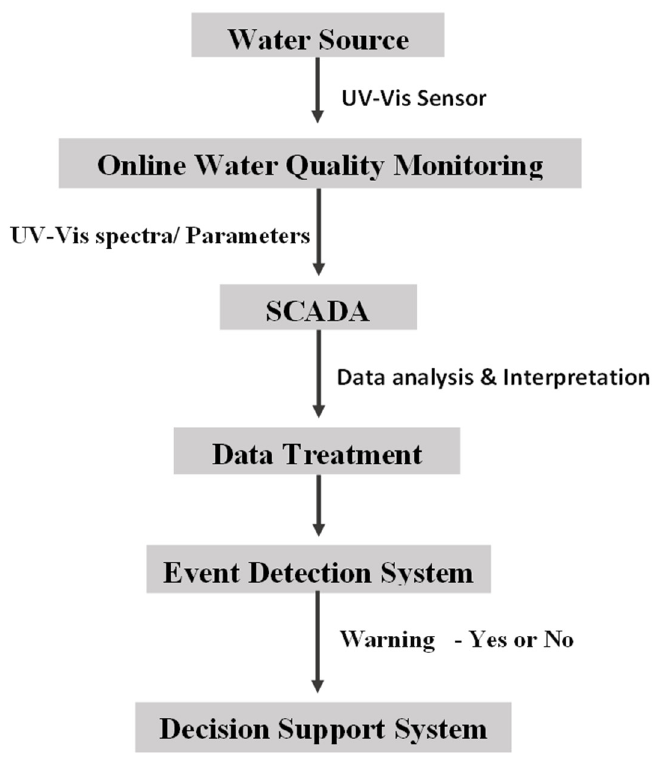
Figure 2. Structure of an early warning